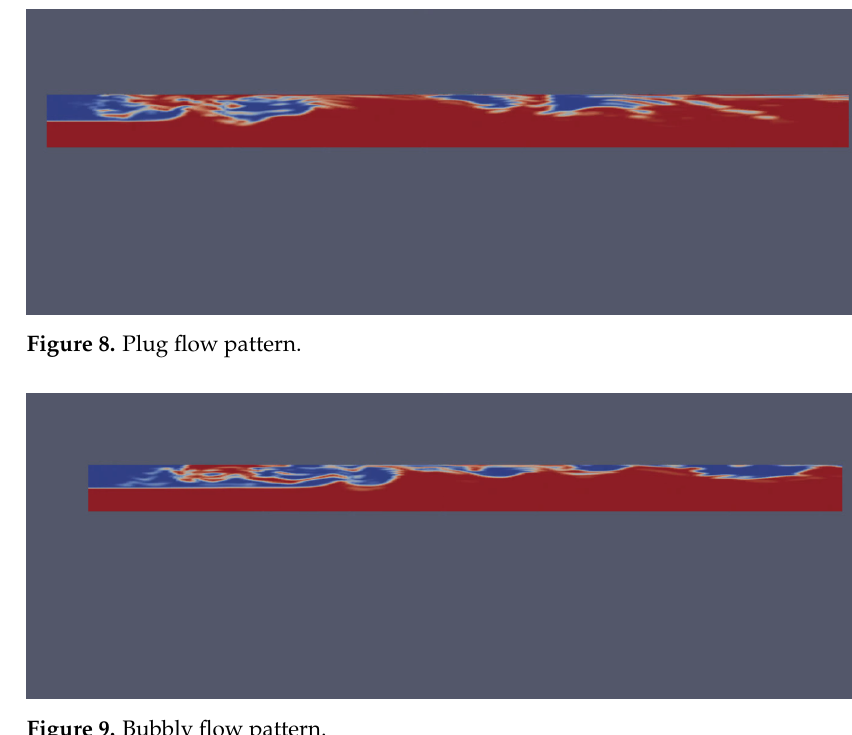
Figure 9. Bubbly flow